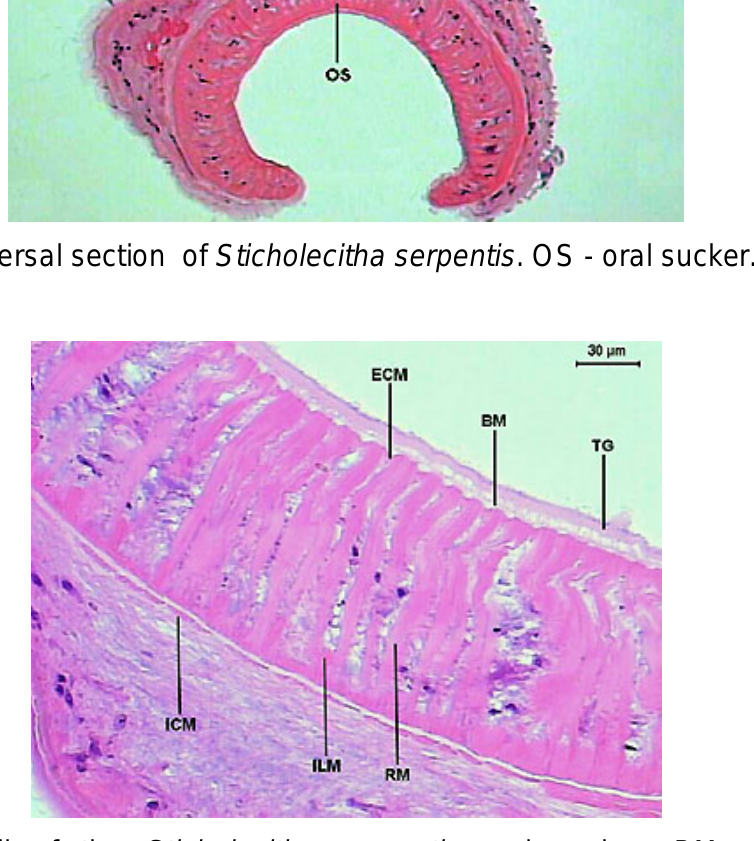
Figure 5. Detail of the Sticholecitha serpentis oral sucker. BM – basement membrane, ECM – external circular musculature, ICM – internal circular musculature, ILM – internal longitudinal musculature, RM – radial musculature, TG – tegument.